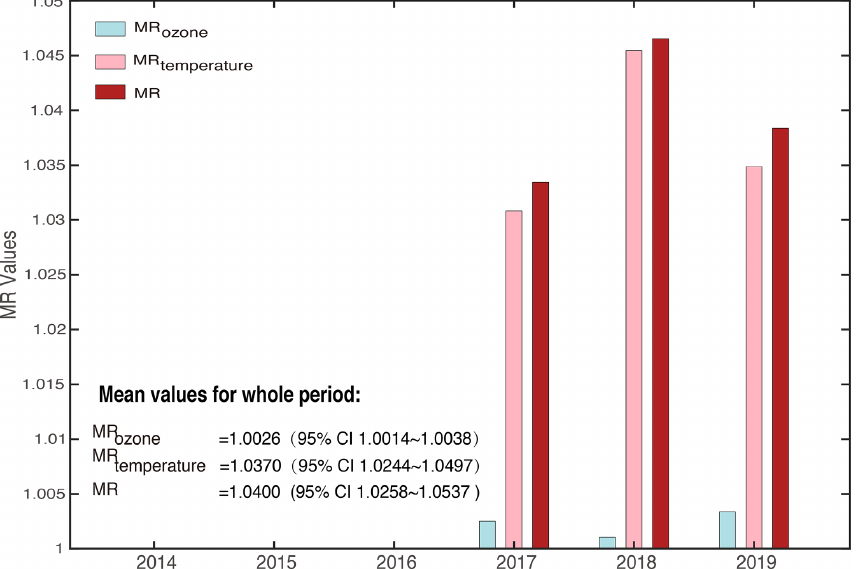
Figure 5. MR ozone , MR temperature , and MR between OPCs and OPCs during May to September for each year of 2017–2019. The average values for 2017–2019 are given in the left corner. MR ozone , MR temperature , and MR indicate the mortality changes between OPCs and OPIs due to differences in O 3 levels alone, air temperatures alone, and both O 3 levels and temperatures,